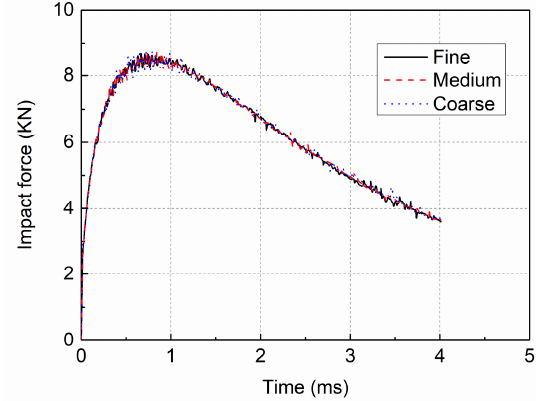
Figure 3. The impact force with different mesh densities during the free-fall water entry of the sphere. Three time-steps, t Δ = 1 × 10 −6 , 2.5 × 10 −6 , and 5 × 10 −6 s, were discussed in the time-step convergence study. The mesh configuration with medium density was chosen.